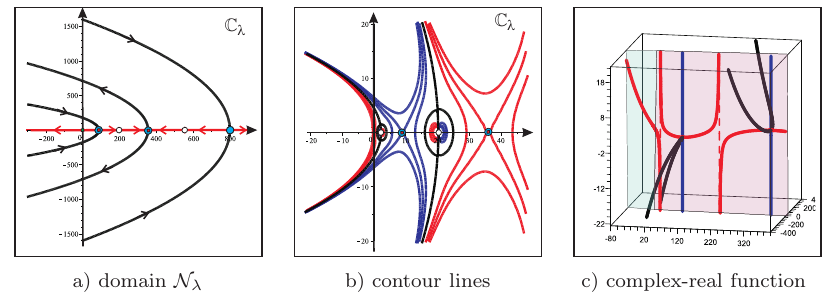
Figure 16. Complex-real function ˜ γ : C λ